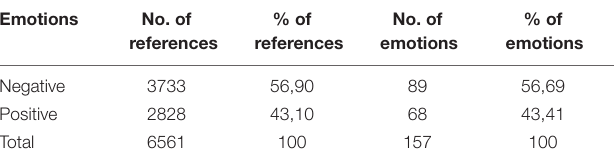
TABLE 1 | Frequency and percentage of quotes and emotions. TABLE 2 | Frequency and percentage of emotions, feelings and states of